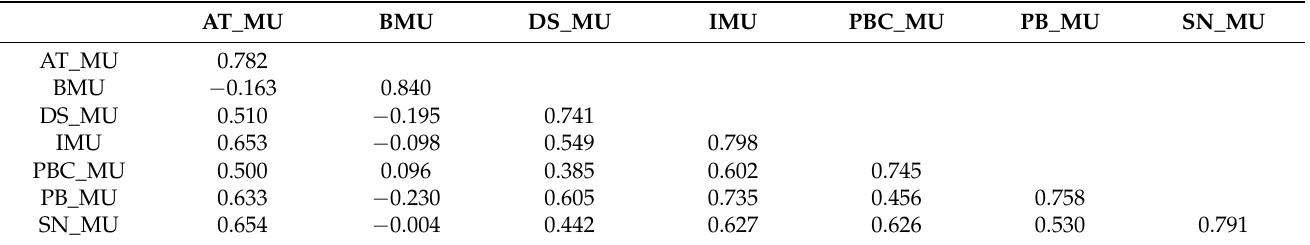
Table 5. Heterotrait–Monotrait Ratio